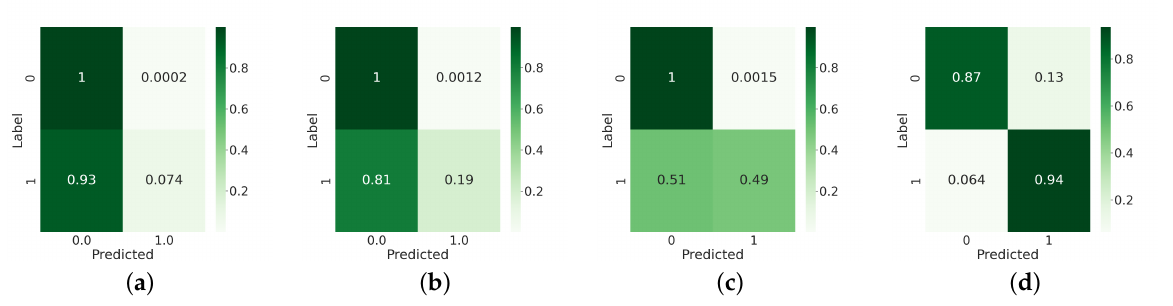
Figure 7. Confusion matrices of ( a ) RF PUL , ( b ) ENSEMBLE PUL , ( c ) OCSVM, and ( d ) PUL-SITS considering the case in which the land cover class of interest (the positive class) is Forest with the number of positive training objects ( n ) equal to